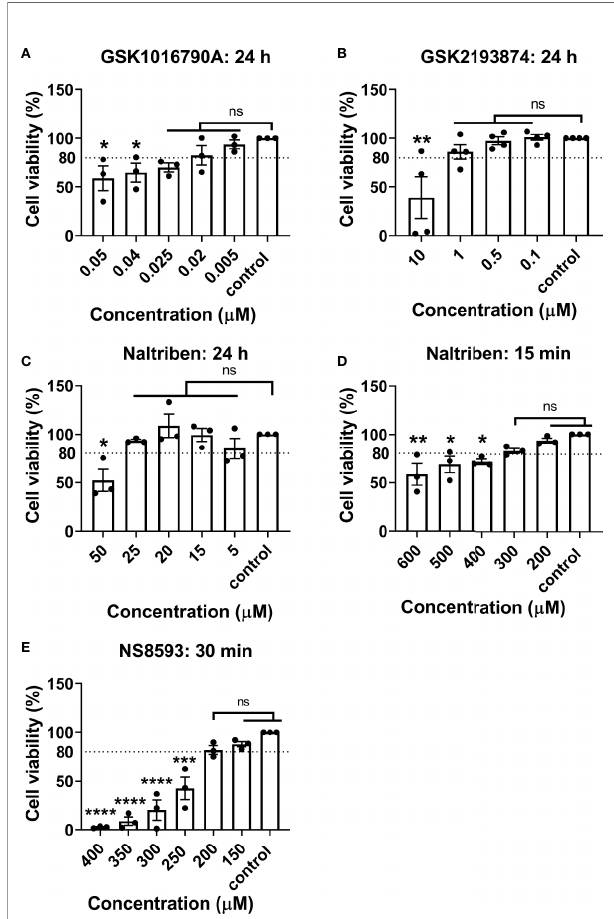
FIGURE 3 | MTT results of bovine NP cells after different incubation periods with (A) GSK1016790A (TRPV4 activator), (B) GSK2193874 (TRPV4 blocker), (C, D) Naltriben methanesulfonate hydrate (TRPM7 activator), and (E) NS8593 hydrochloride (TRPM7 blocker). Graphs show percentage of viable cells (mean ± SEM, bNP P2, n = 3 – 4). Asterisks indicates statistical signi fi cance compared to the untreated control (*p < 0.05, *p < 0.01, ***p